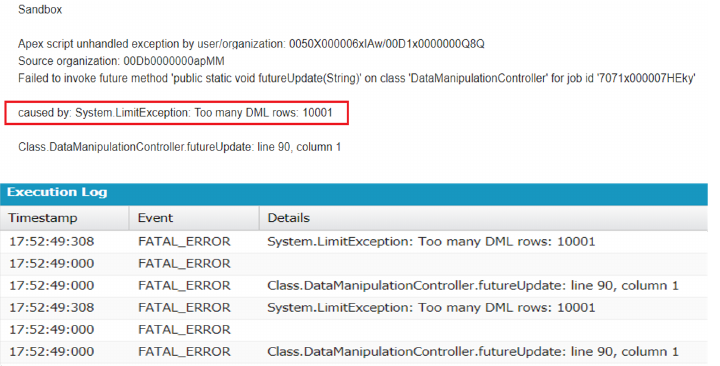
Figure 5. Exceeding the DML operation limit—email notification and collected processing logs in the development console.